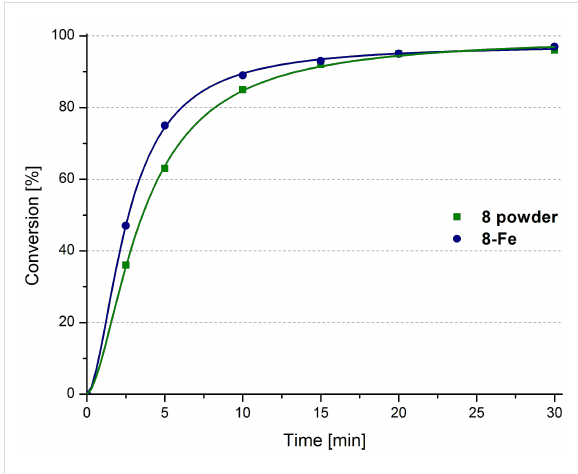
Figure 8: RCM of 9 catalysed by 8 and 8 -Fe. Conditions: 1 mol % catalyst, toluene 80 °C, [9] = 0.2 M.